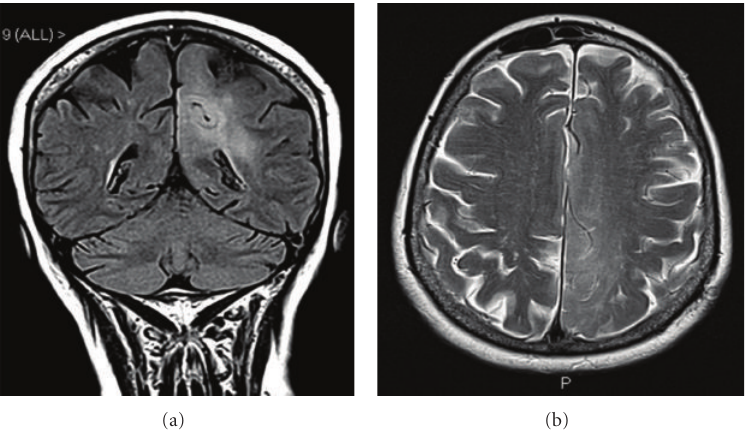
Figure 1: Coronal FLAIR (a) and axial T2 weighted images (b) showing extent of the lesion on MR scan taken at the time of MRS.